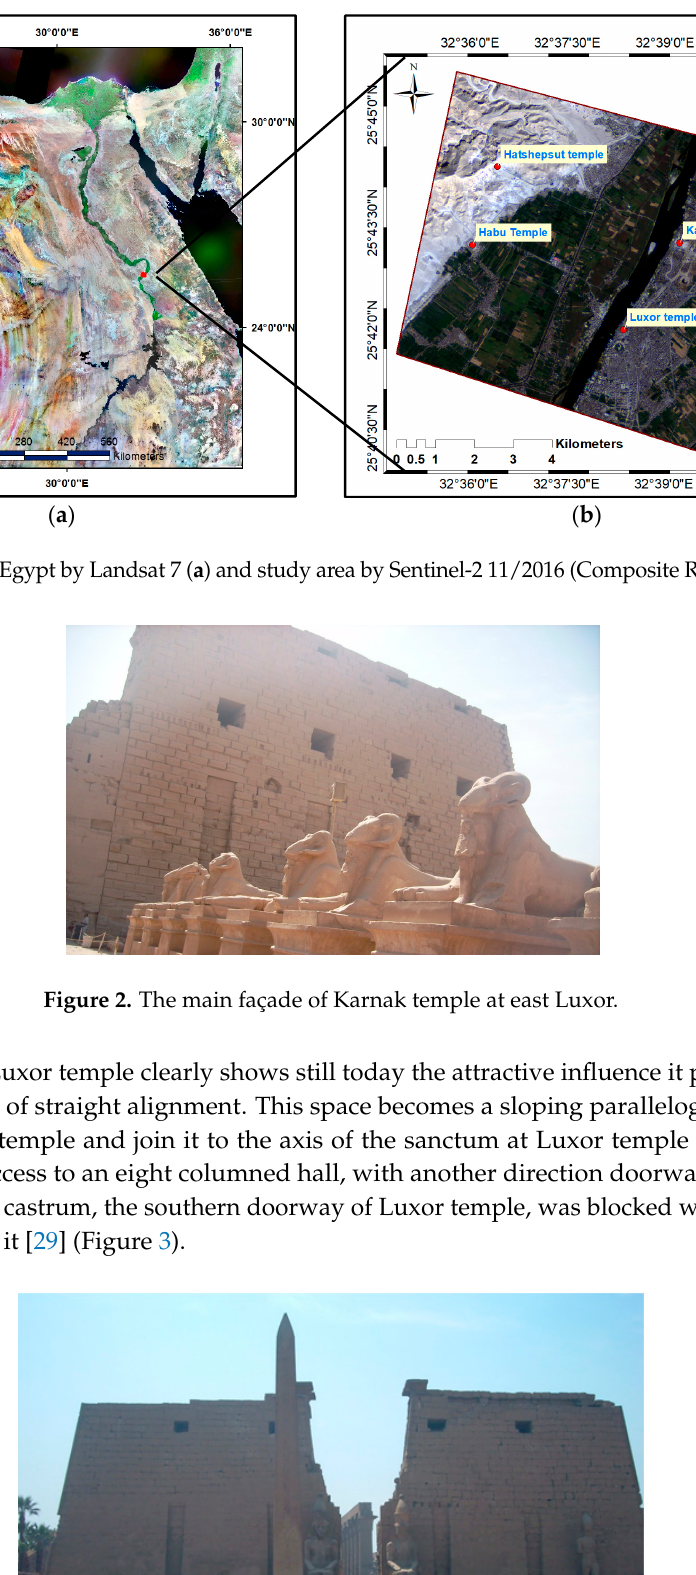
Figure 3. The main façade of Luxor temple at east Luxor.